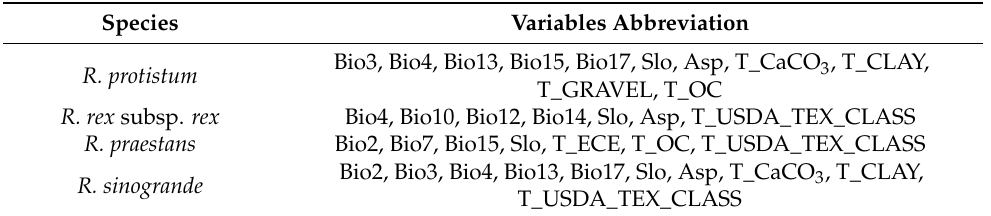
Table 1. Environmental predictors used for modeling the habitat suitability distribution of four Rhododendron